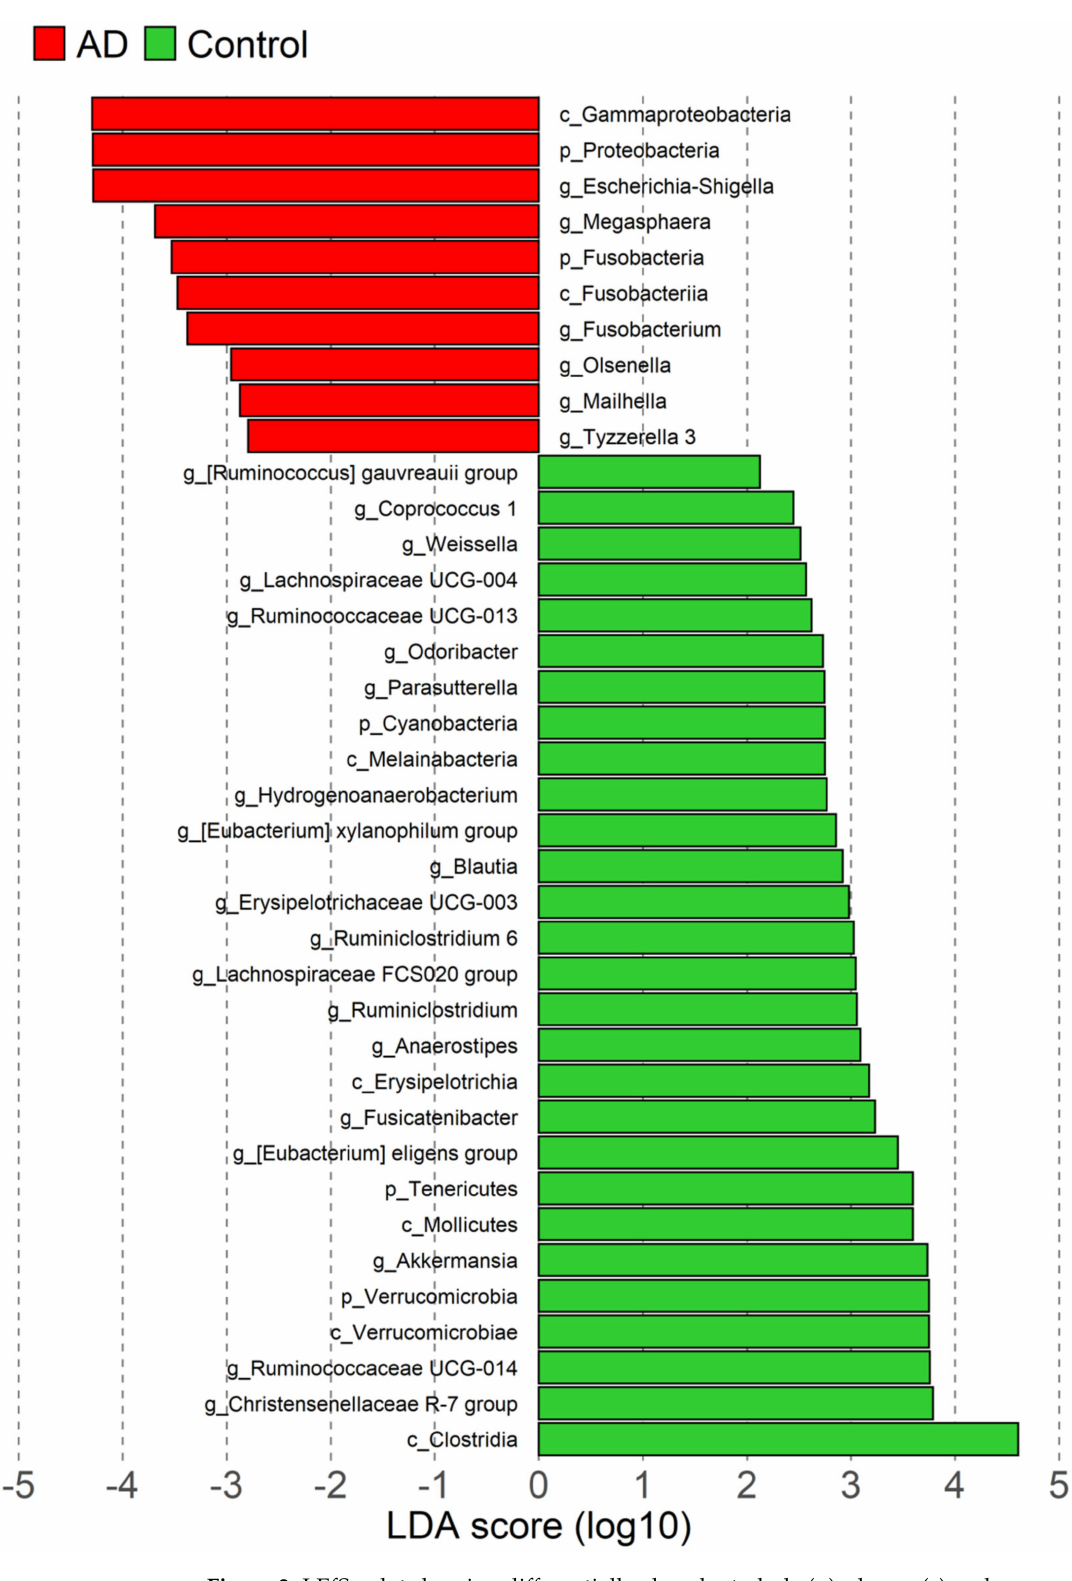
Figure 3. LEfSe plot showing differentially abundant phyla (p), classes (c) and genera (g) between controls (green) and atherogenic dyslipidemia (AD) subjects (red). LDA score > 2.0 and p < 0.05 indicate statistically significant